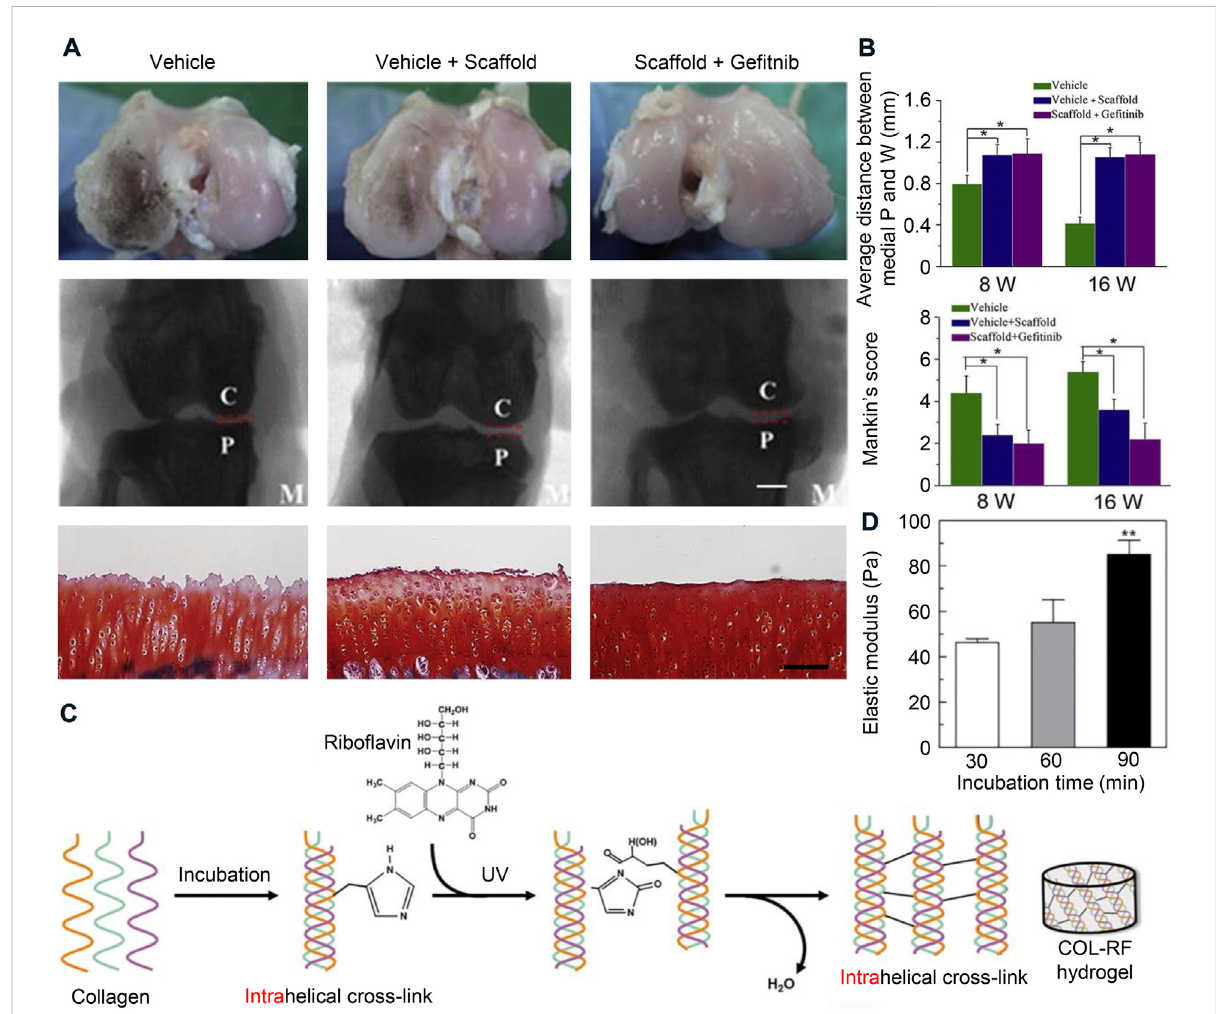
FIGURE 5 Collagen materials used for meniscus tissue engineering. (A) Gross morphology, radiological analysis, and histological staining of the femoral cartilagesurfaceafterimplantationofcollagenscaffold.Bar=200 μ m.C,condylesoffemur;P,tibialplateau;M,medialofthekneejoint. (B) Average distance between medial knee joint, and histological evaluation according to Mankin ’ s scoring system. Reprinted with permission (Pan et al., 2017). Copyright (2017), Elsevier. (C) Synthetic routes of ribo fl avin-induced photocrosslinked collagen (COL-RF) hydrogel. (D) The relationship between elastic modulus and incubation time. Reprinted with permission (Koh et al., 2017). Copyright (2017),